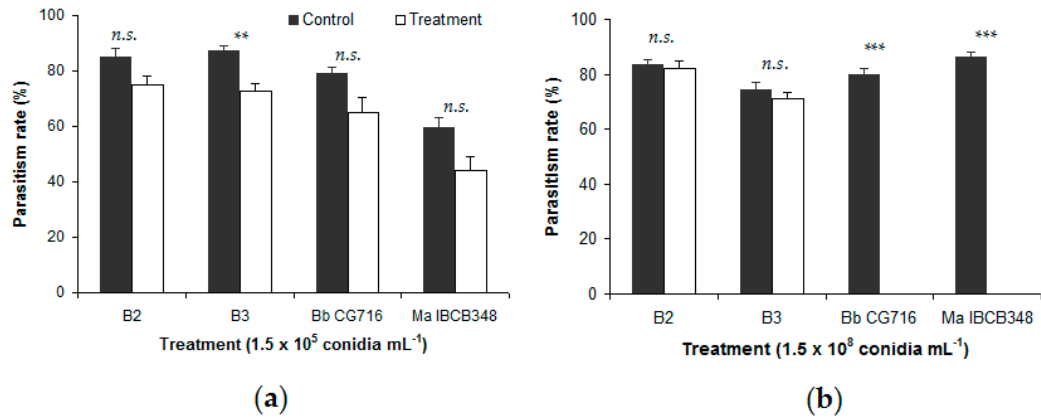
Figure 1. Percentage of Duponchelia fovealis eggs parasitized by Trichogramma atopovirilia in free-choice tests, comparing eggs sprayed with Beauveria bassiana strains (B2 and B3) and commercial bioinsecticides (Bb CG716 and Ma IBCB348) vs. control solutions: ( a ) 1.5 × 10 5 conidia mL − 1 ; ( b ) 1.5 × 10 8 conidia mL − 1 . Error bars indicate standard errors (n = 15). Significant differences between a given treatment (entomopathogen) and its corresponding control (water), according to the Wilcoxon test, are shown over the bars as follows: n.s. = not significant; ** = p -value < 0.01; *** = p -value < 0.001.